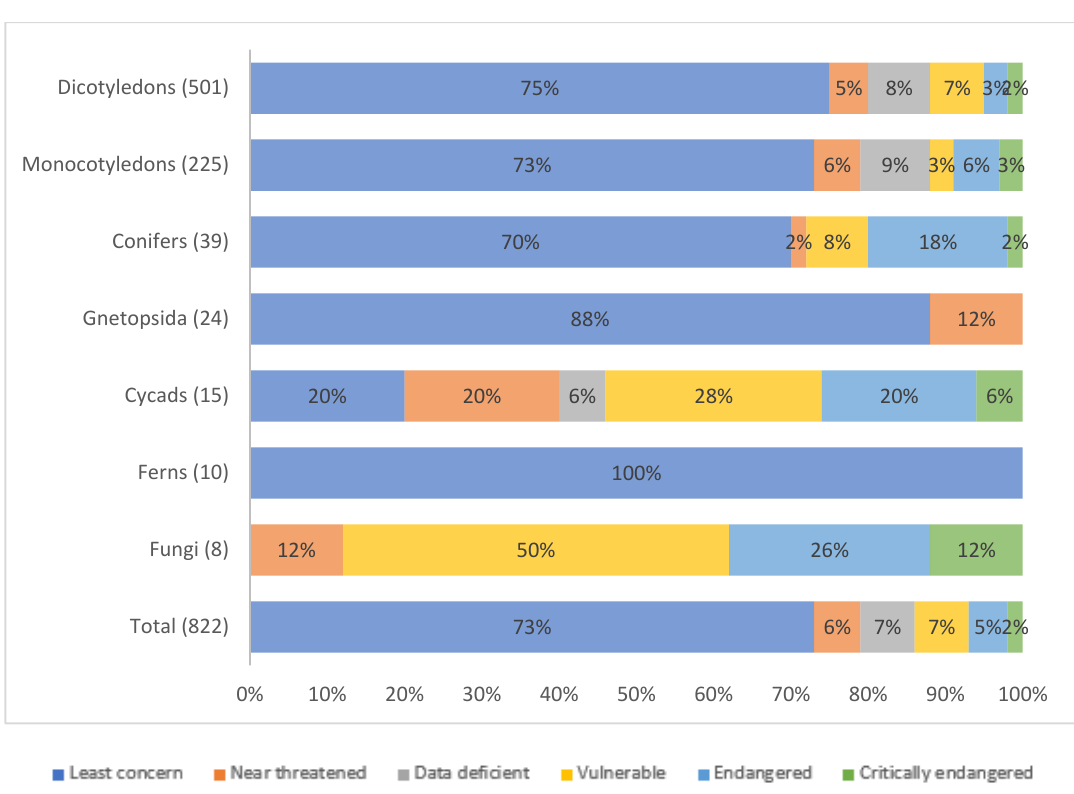
Figure 1. Number of WFPs and fungi on the IUCN Red List of Threatened Species classified by class and risk category Source: IUCN Red List 2017. Adapted from FAO [45].